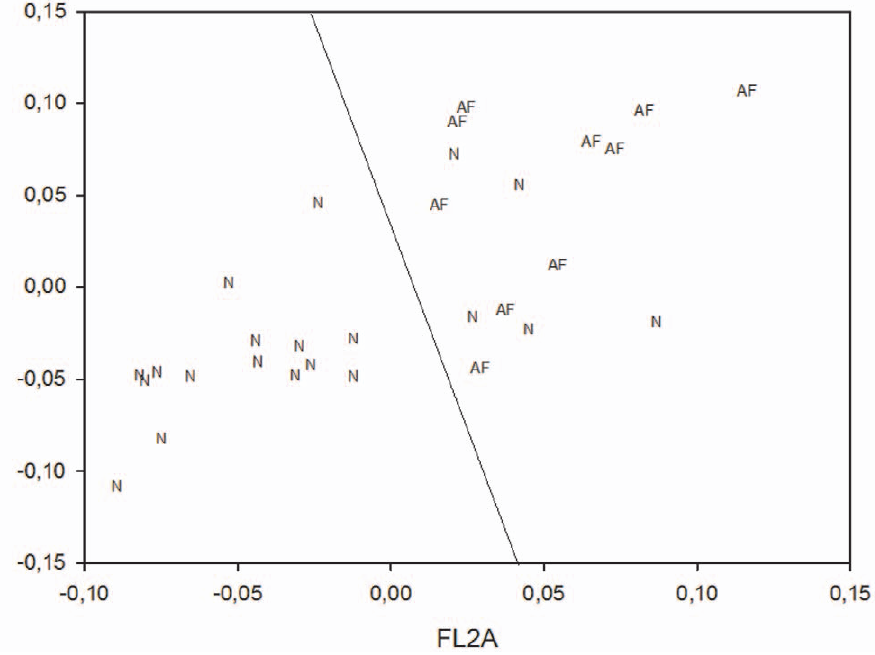
Figure 1. The graph axes are the genome-wide profiles of two samples (an AF and a control one), the vector points are the single genes. The overwhelming order parameter correlating around 20000 genes expression values is evident. The line roughly corresponds to PC1. doi:10.1371/journal.pone.0013668.g001 PLoS ONE |